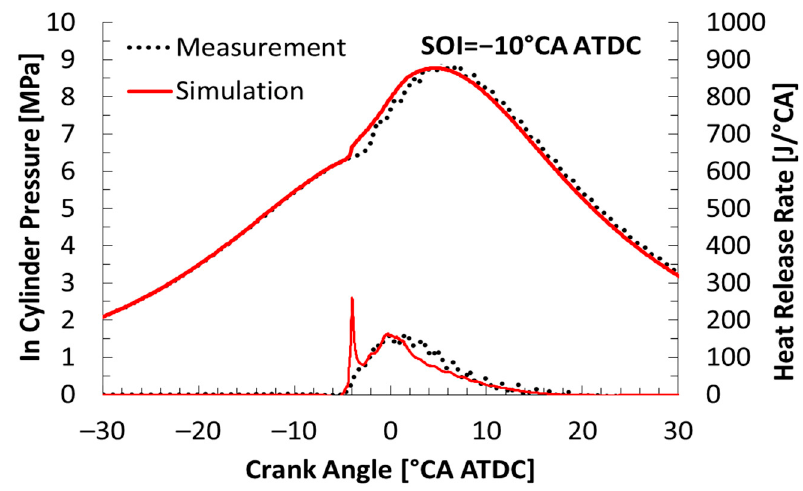
Figure 4. Comparison of experimental and CFD simulation results of in-cylinder pressure and AHRR histories for SOI of − 10 °CA ATDC.